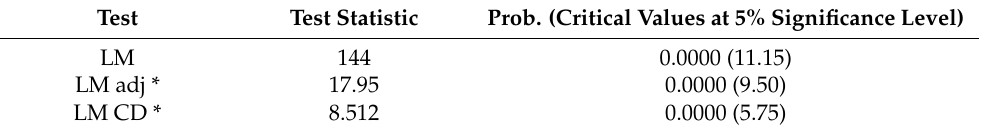
Table 3. Cross-sectional dependence tests’ findings.